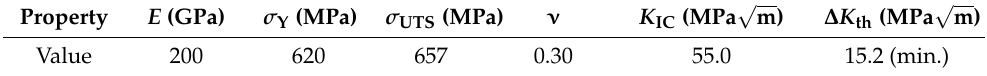
Table 1. Mechanical and fatigue fracture properties of AISI 410 martensitic steel. Property